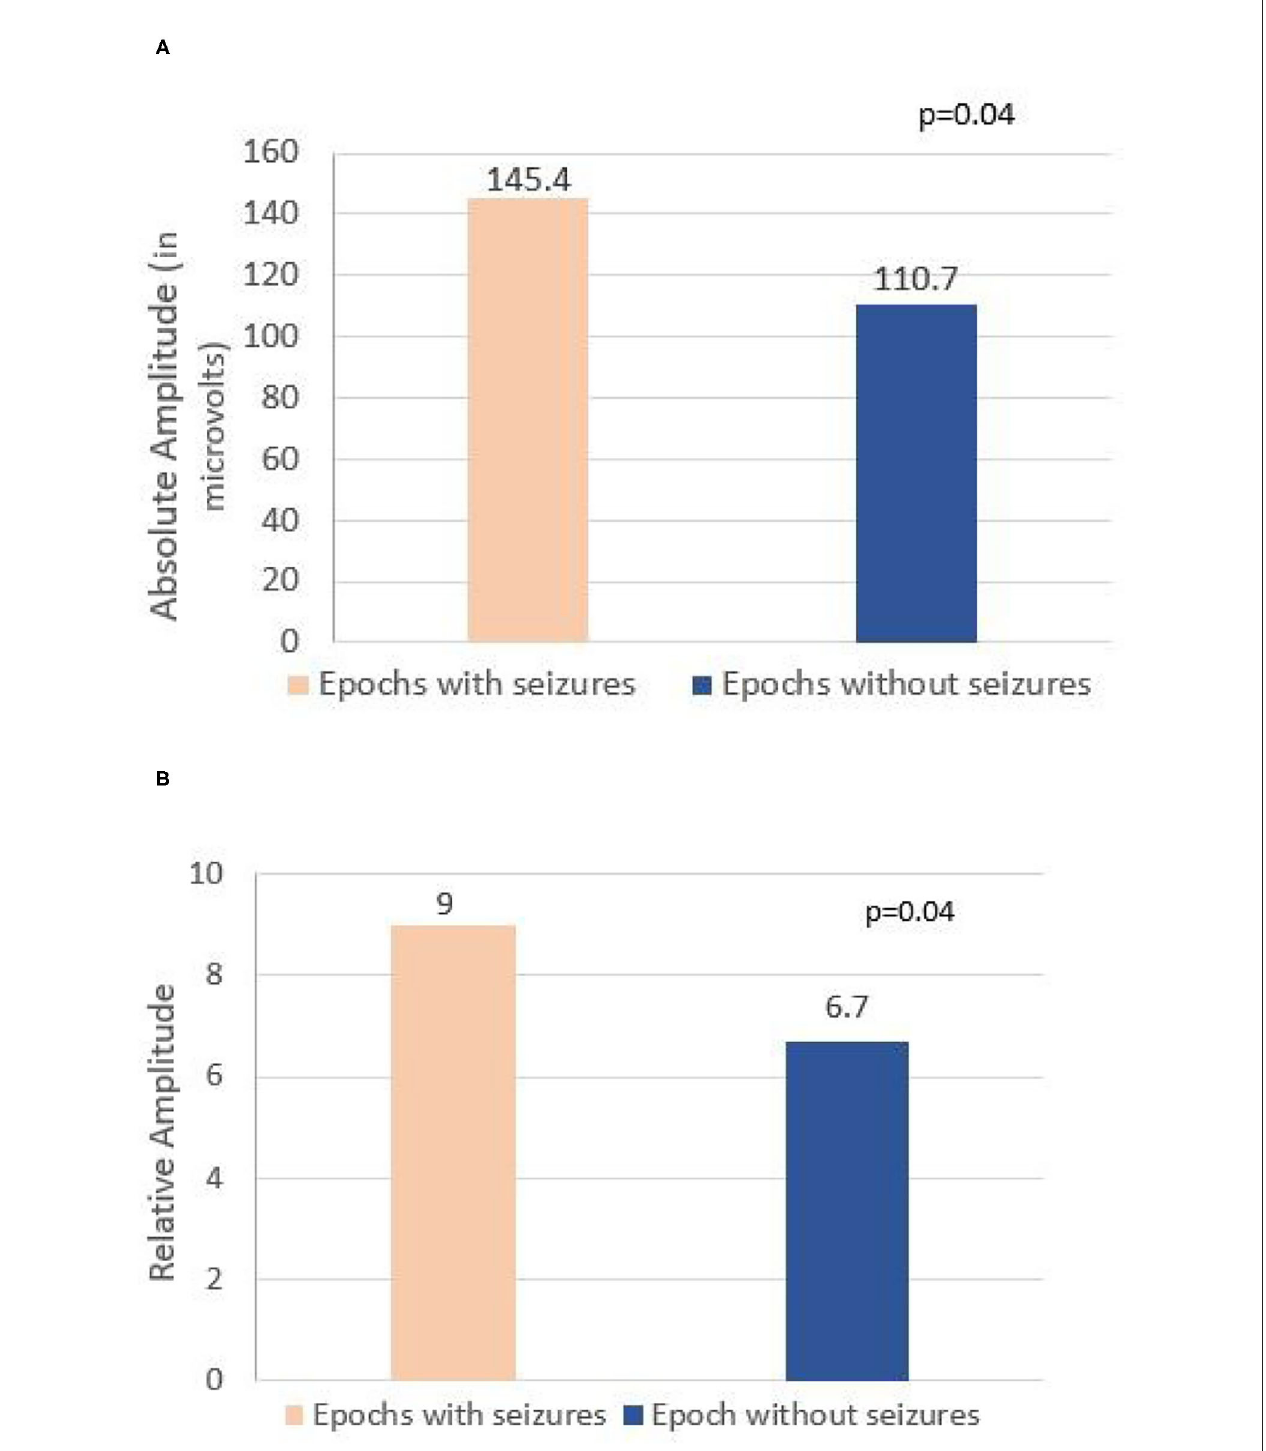
FIGURE 1 | (A) Comparison of absolute amplitude of lateralized periodic discharges (LPDs) between epochs with seizures and epochs without seizures in all 20 patients. (B) Comparison of relative amplitude of LPDs between epochs with seizures and epochs without seizures in all 20 patients.